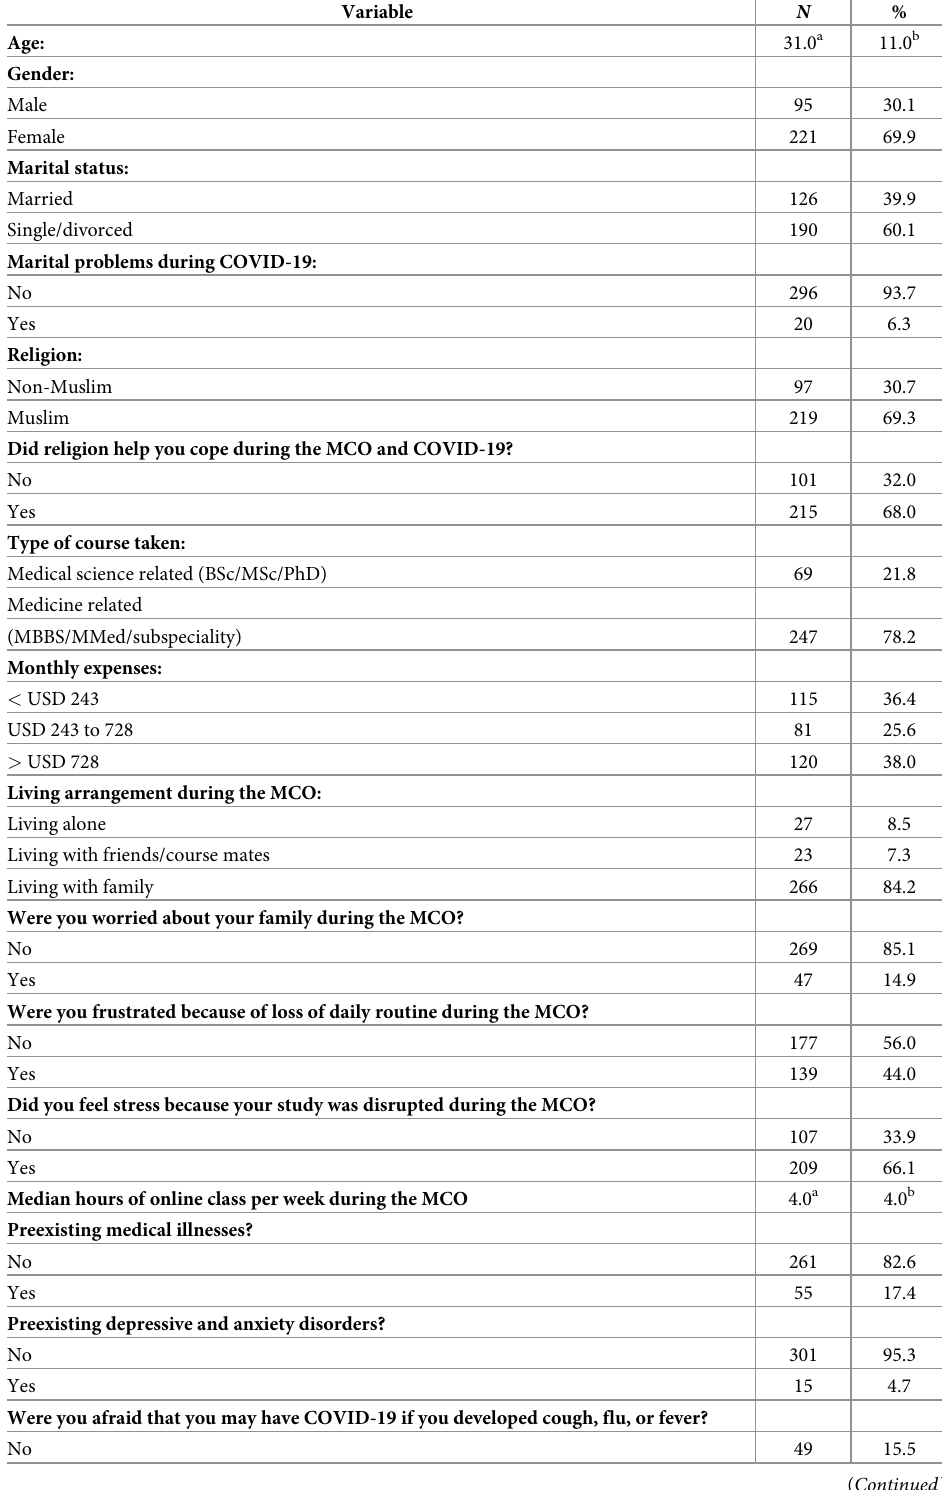
Table 1. Sociodemographic and personal characteristics, COVID-19-related stressors and coping, and clinical fac- tors of the